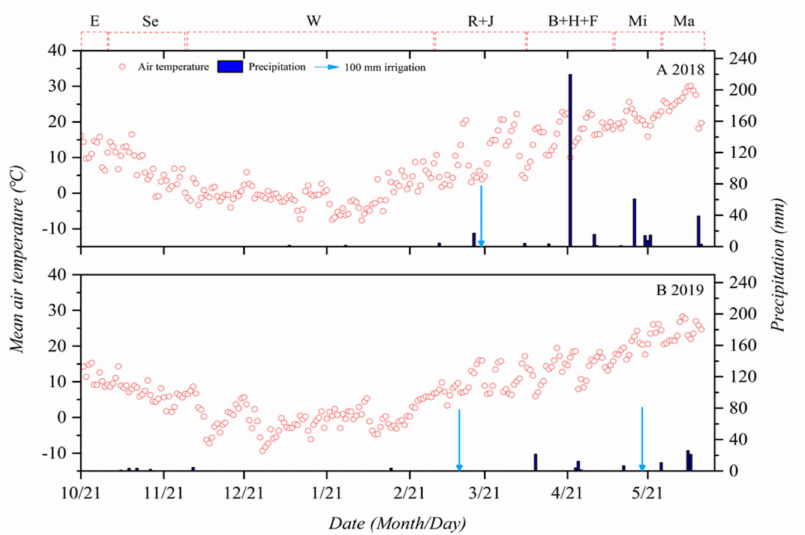
Figure 1. Daily air temperature and precipitation during the wheat growth stages in 2017–2019. Red dash line is used to mark the wheat growth stages: E, emergency; Se, seedling; W, wintering; R + J: Returning green and Jointing; B + H + F: Booting, heading and flowering; Mi: Milking; Ma: